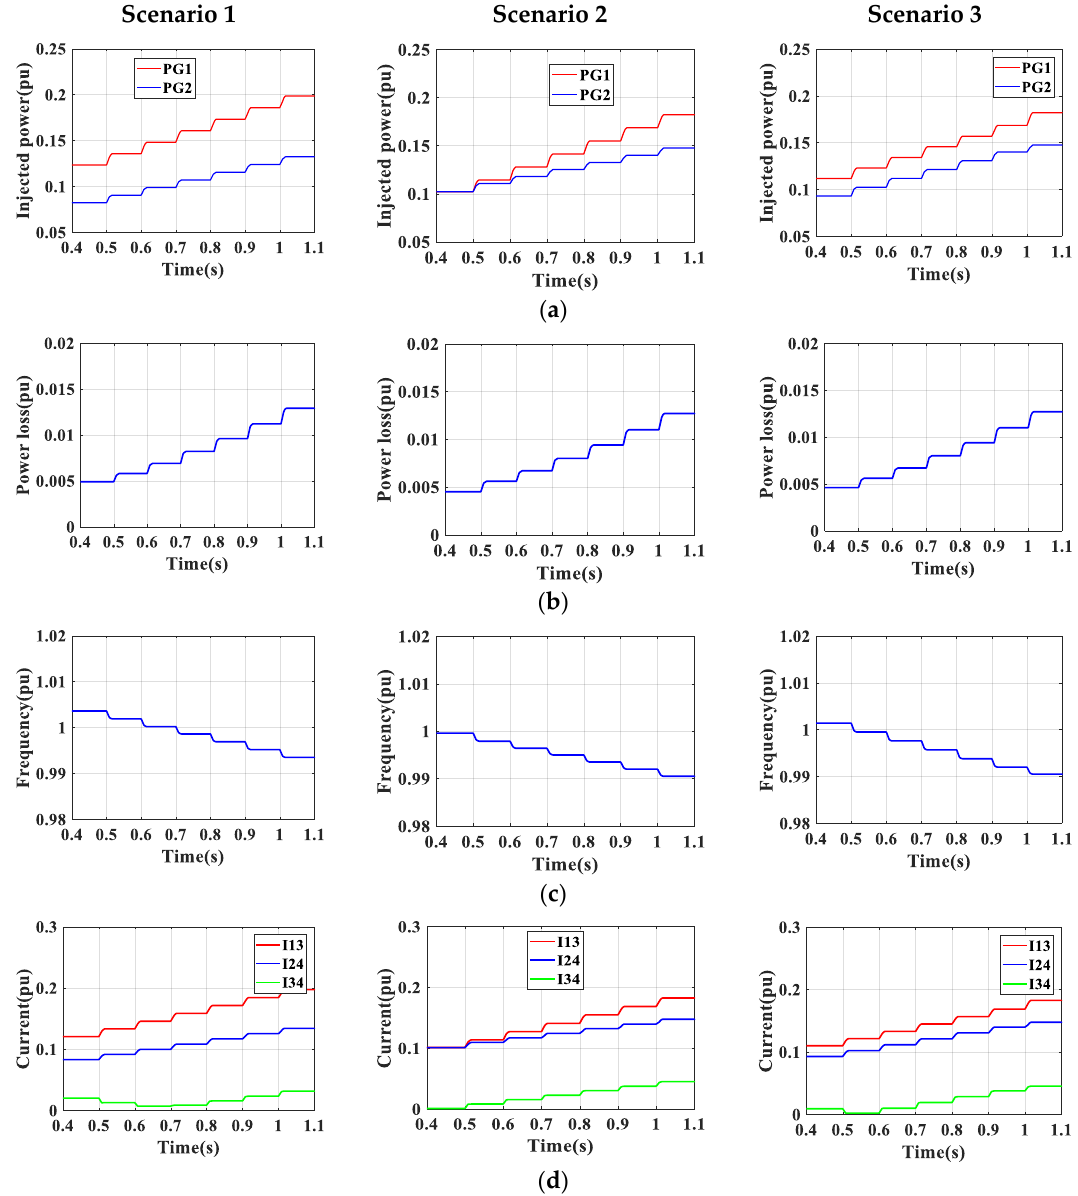
Figure 9. Simulation results: ( a ) Real power of the distributed generators in the three scenarios; ( b ) Power losses of the microgrid in the three scenarios; ( c ) System frequency in the three scenarios; ( d ) Current of branches in the three scenarios.